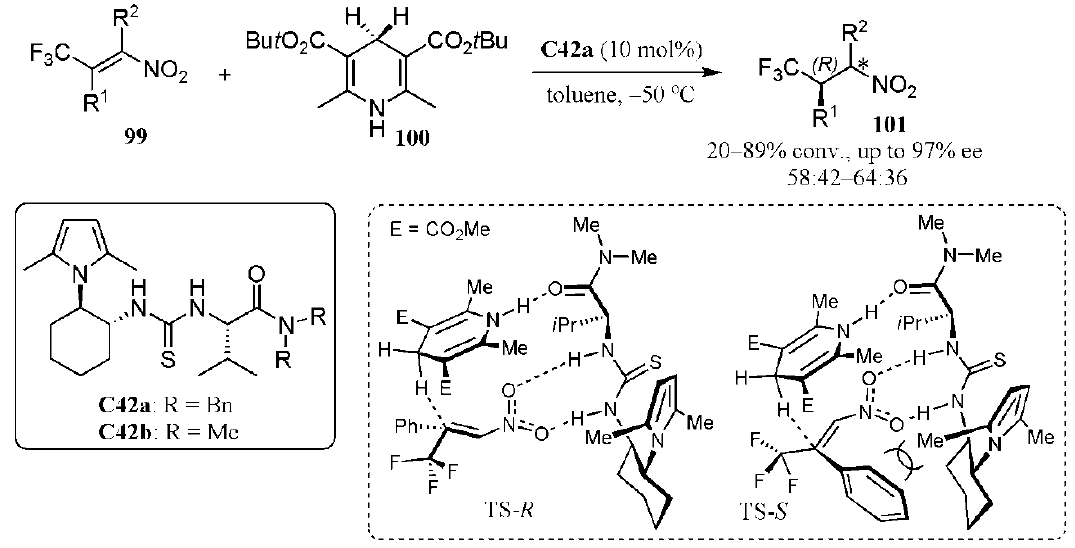
Figure 52. Enantioselective organocatalytic reduction of β -trifluoromethyl nitroalkenes 99 [101]. Qiu, Zhao and coworkers described a Morita–Baylis–Hillman reaction of N -alkyl isatins 102 with acrylates 103 catalyzed by a bifunctional phosphine–squaramide ( C43 ) in 2015 (Figure 53) [102]. The catalyst was part of a series synthesized from inexpensive and commercially available β -amino alcohols. The products, chiral 3-substituted 3-hydroxy-2-